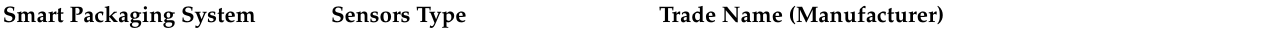
Table 5. Commercially available intelligent packaging and active packaging systems, reproduced with permission from [98]. Smart Packaging